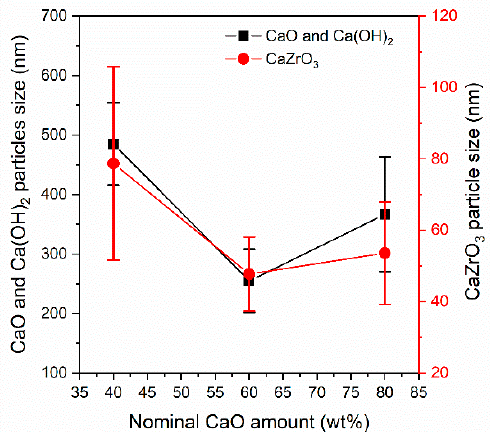
Figure 4. Average size of the CaO, Ca(OH) 2 , and CaZrO 3 particles measured by SEM of as–prepared CCZ samples.